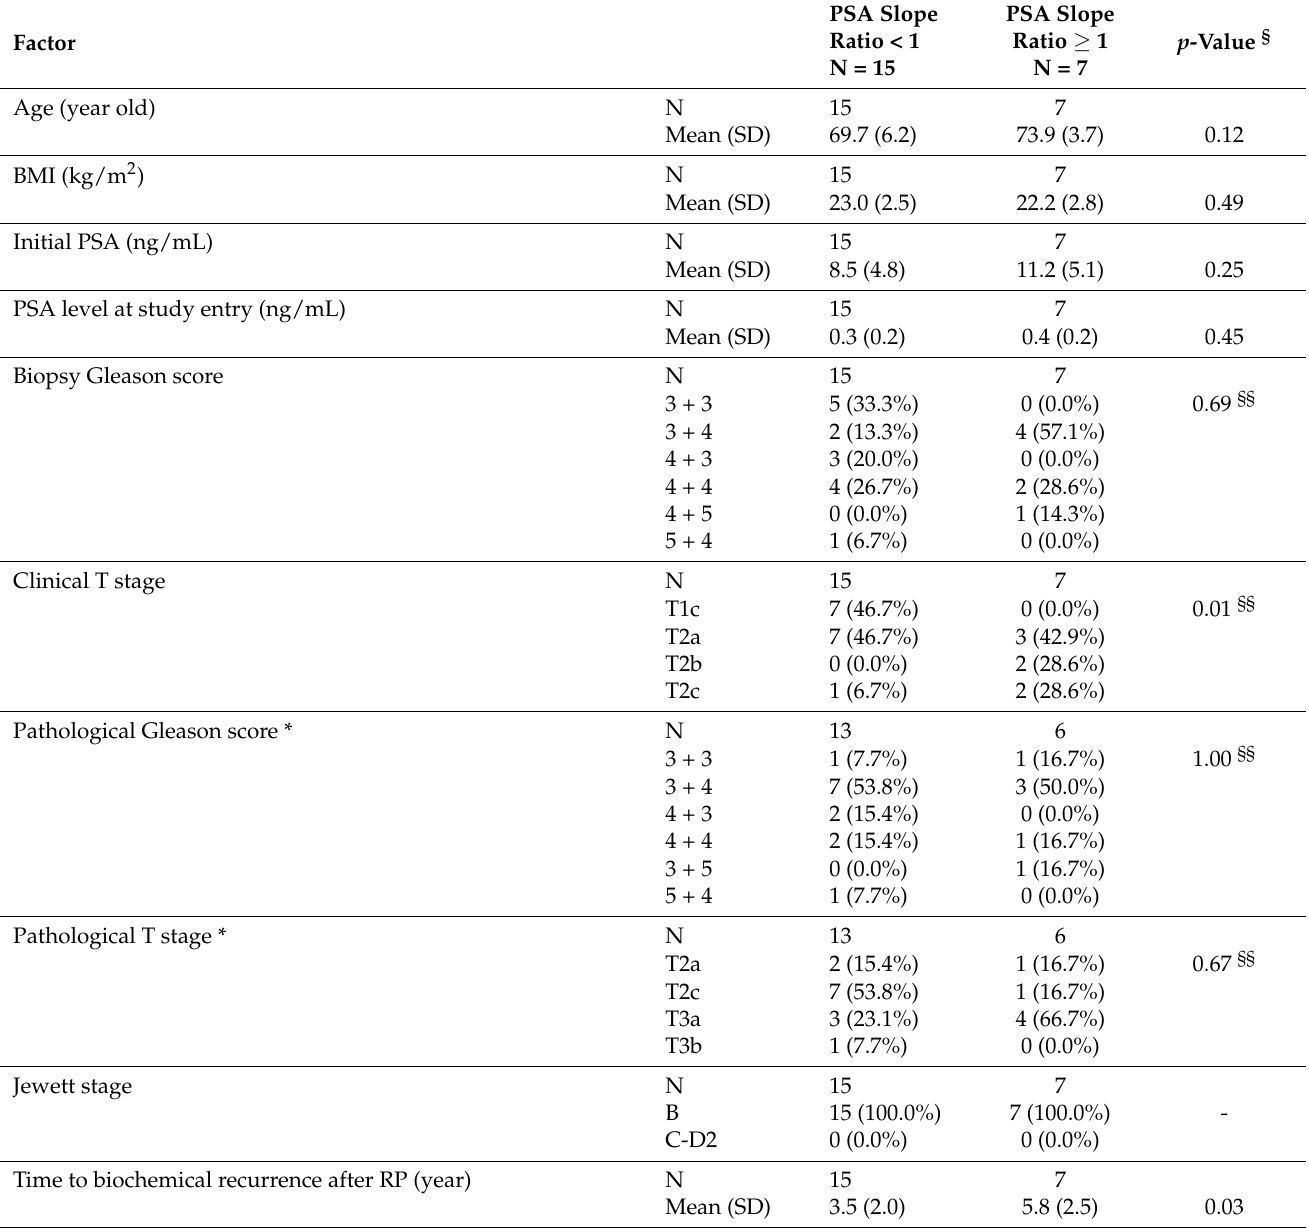
Table 2. Characteristics of the two groups: prostrate-specific antigen slope ratio < 1 group and prostate-specific antigen slope ratio ≥ 1